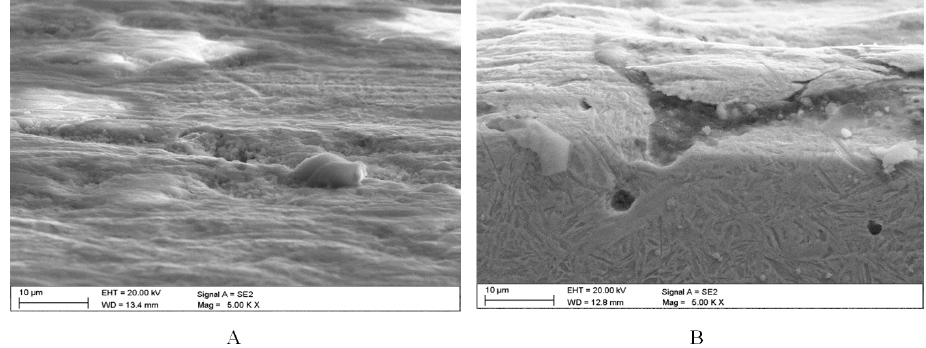
Figure 10. Damage to the surface of the wheel made of the GS42CrMo-4 cast steel, ( A )—caused by grains of quartz abrasive, ( B )—caused by fatigue processes, SEM.